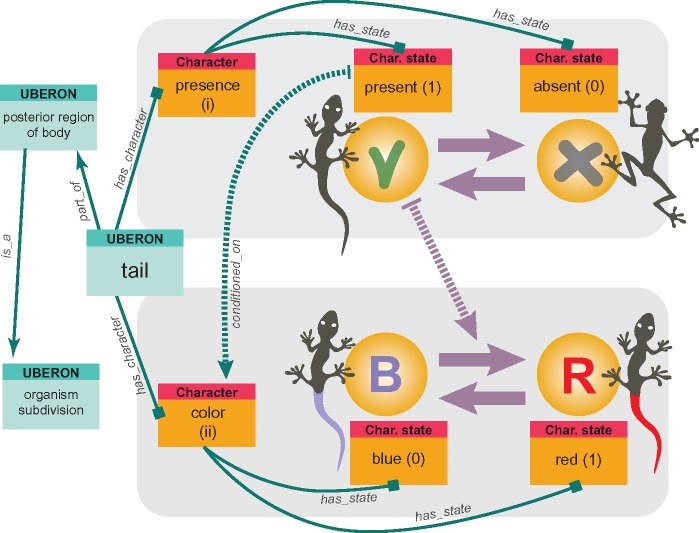
Ontology-informed character. The tail characters linked with ontology. The links (i.e., arrows) show various types of ontological relationships between the characters and between entities of UBERON anatomy ontology.